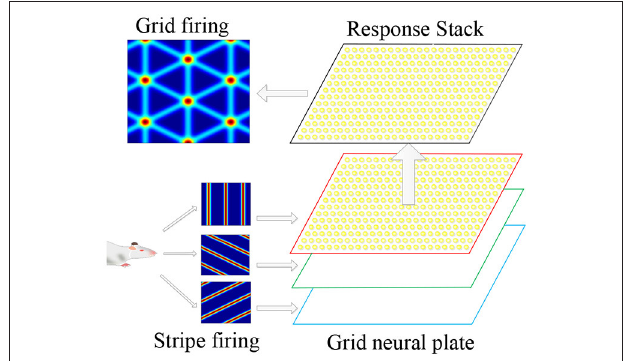
FIGURE 4 | Schematic diagram of grid cells model coding principle. According to the movement information of the robot, the striped firing response is formed in the stripe cells. The striped firing signals are projected onto the grid cells, forming a grid-like firing